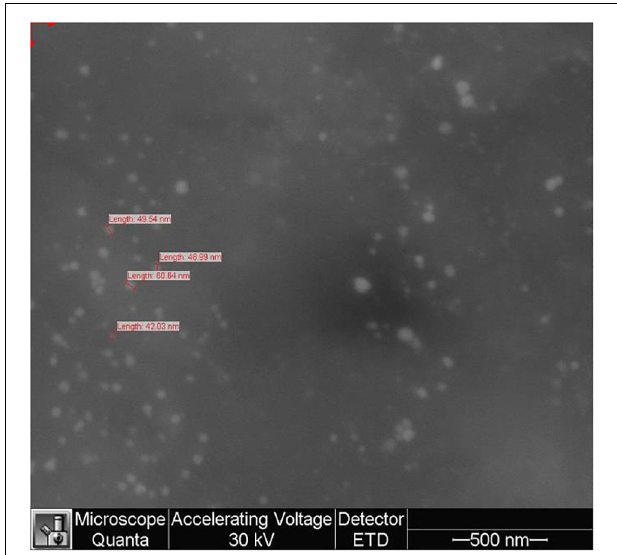
FIGURE 3 | Scanning electron microscopy (SEM) analysis of gold nanoparticles sample (AuNP).